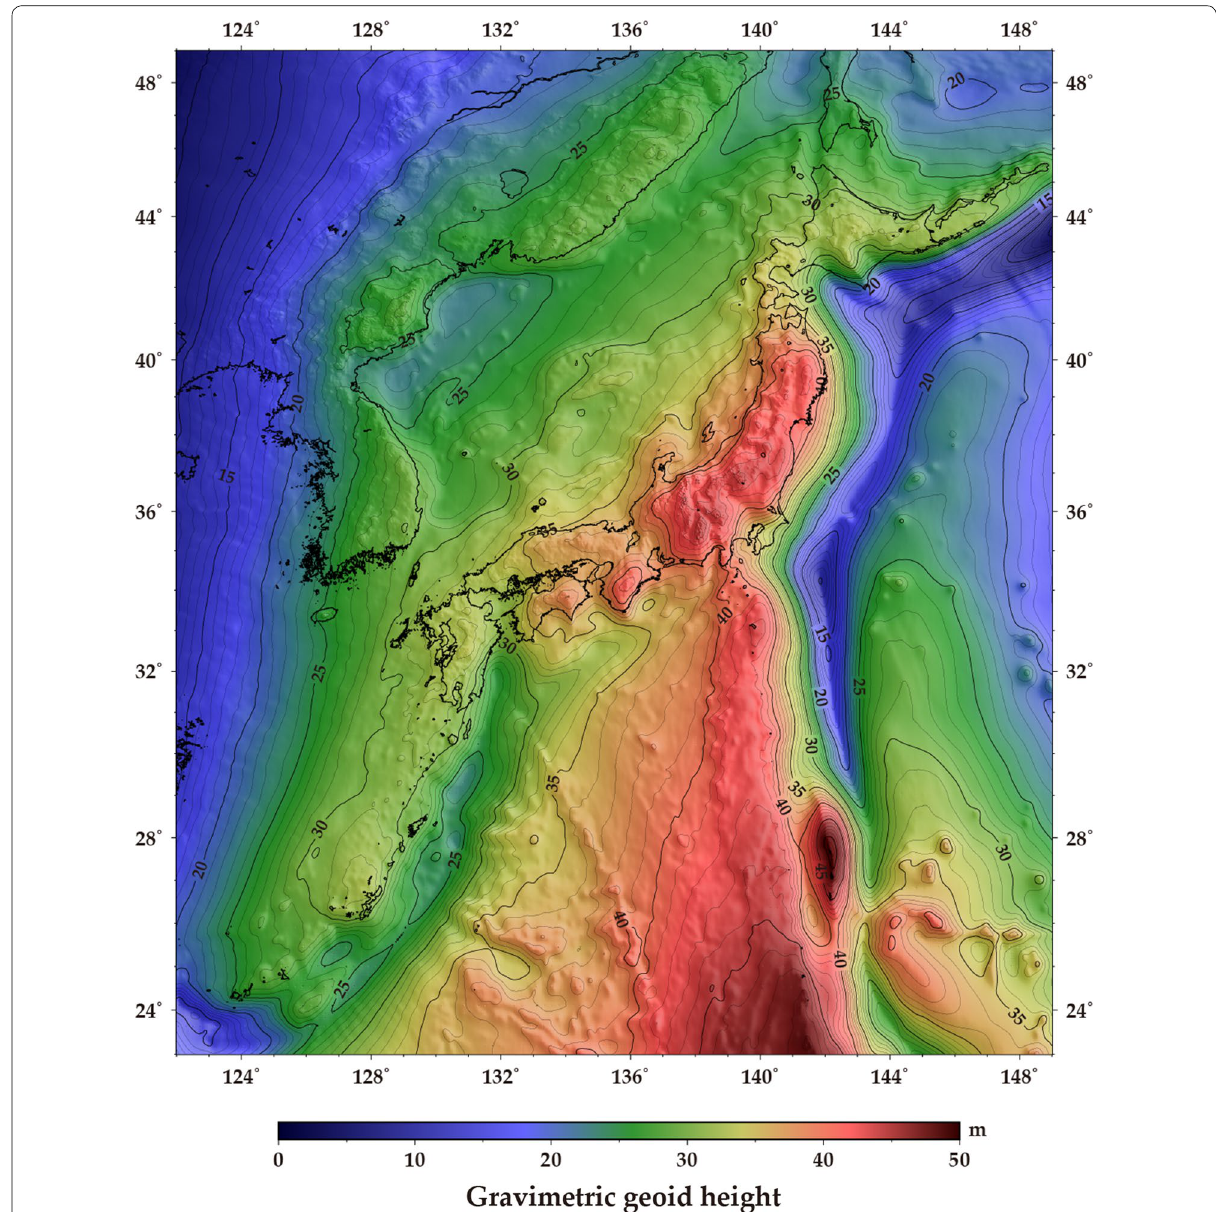
Fig. 4 Geographical map of the gravimetric geoid model developed in this